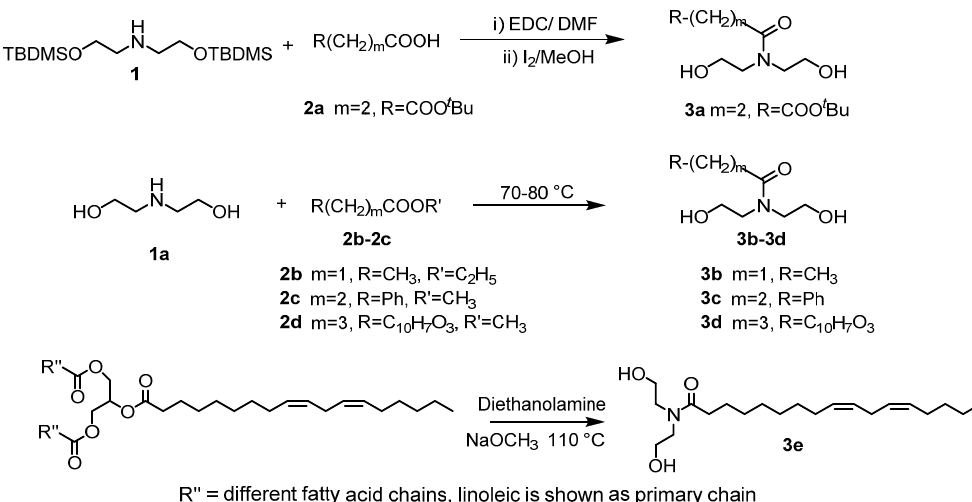
Figure 2. Synthesis of diols with different pendant groups.